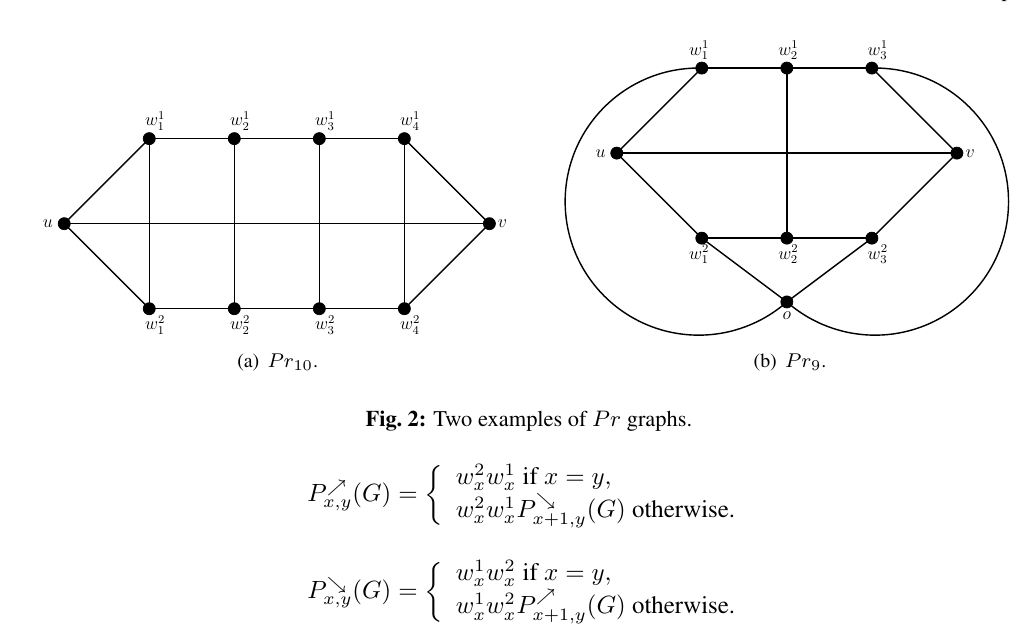
Fig. 2: Two examples of Pr